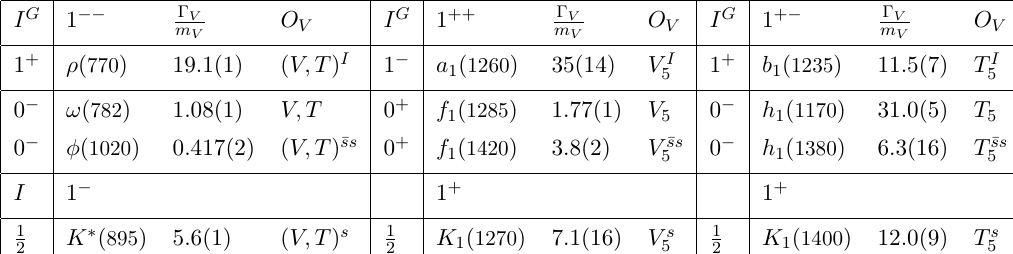
Table 1 . Mass ( m V ) and width ((cid:0) V ) data for the neutral mesons, from the latest PDG data [31]. Uncertainties in these parameters are also indicated in brackets alongside the central values. The I G and J PC quantum numbers have also been indicated. The K particles are separated, as they do not have de(cid:12)nite G -parity states. The two K 1 -particles are subject to a mixing angle (cid:18) K , which 1 is fortunately known to reasonable accuracy [32]. Mixing between particles in the same column has to be taken into account as well, cf. appendix C of [33] for the discussion of the 1 (cid:0)(cid:0) -states for example. The interpolating operators under the O V -column are described in the main text in (3.1) s . In addition, there and superscripts s and (cid:22) ss denote replacements of the light quarks q !